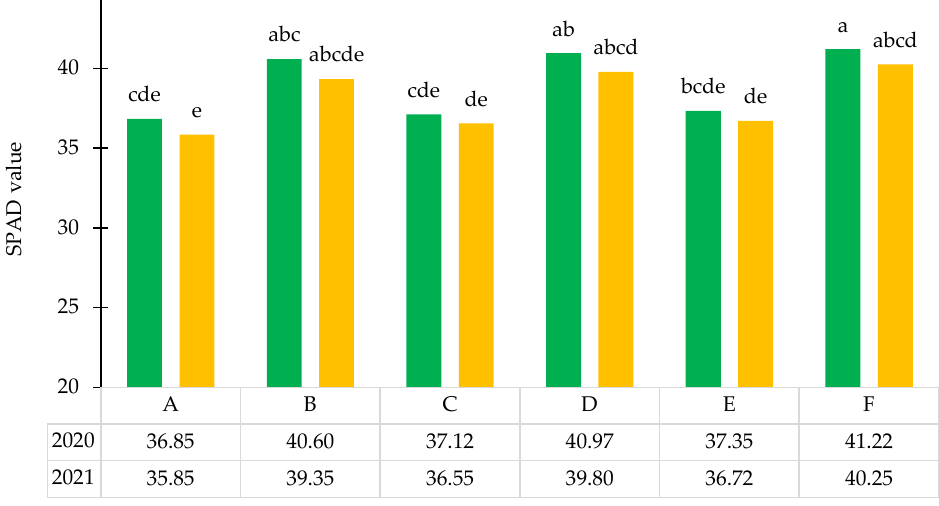
Figure 2. SPAD value. A–F—variants of fertilization. Different lowercase letters indicate significant differences ( p < 0.05) according to the analysis of variance (ANOVA).